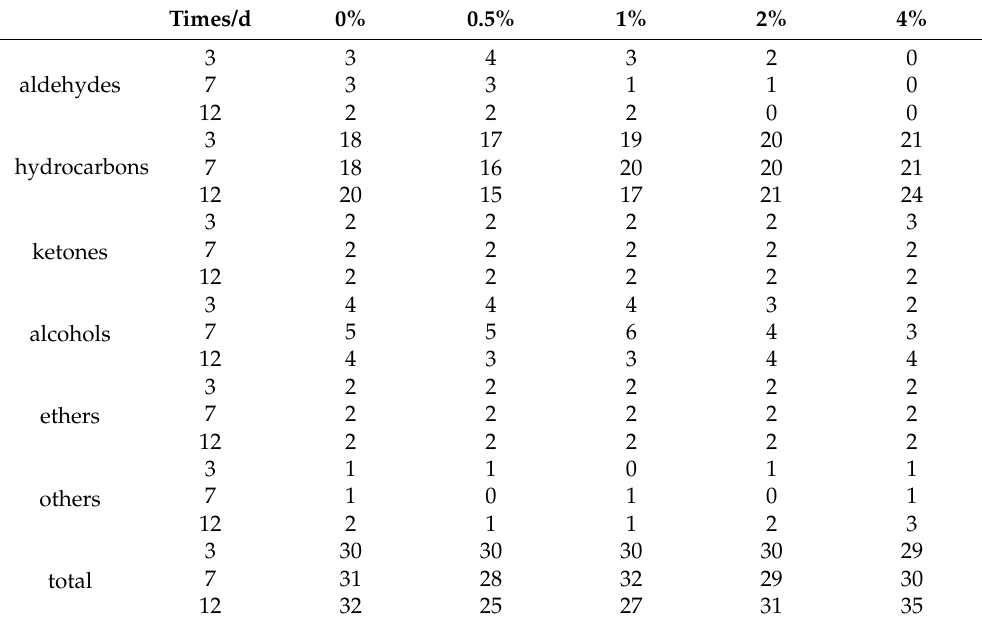
Table 3. Effects of LNT content and storage time on substance types of goose meatballs during cold storage (4 ◦